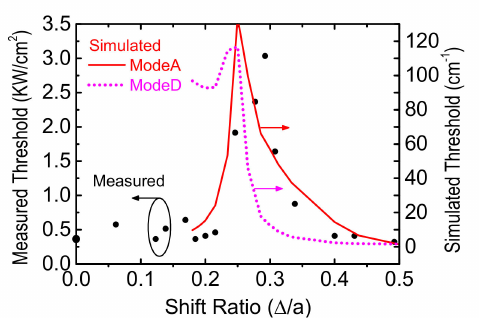
Figure 7. The threshold power density versus shift ratio for 16 experimental devices. The simulated threshold gains of ModeA and ModeD are